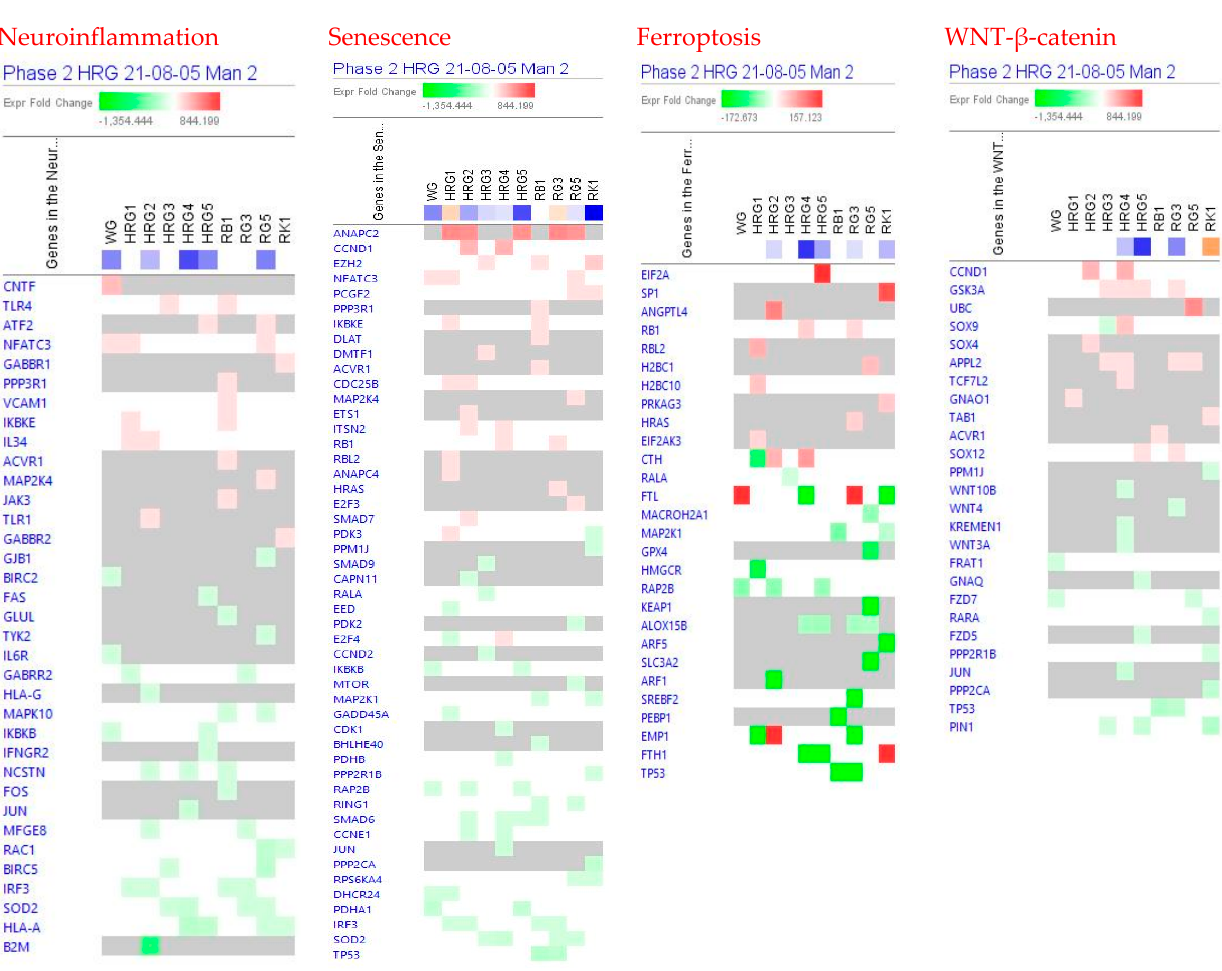
Figure 3. Effects of WG at a concentration of 10 µ g/mL, HRG at concentrations of 10 µ g/mL (HRG1), 1 µ g/mL (HRG2), 100 ng/mL (HRG3), 10 ng/mL (HRG4), and 10 pg/mL (HRG5), and ginsenosides Rb1, Rg3, Rg5 and Rk1 at a concentration of 100 nM on neuroinflammation, senescence, ferroptosis, and WNT— β -catenin signaling pathways. The heatmap of gene expression (in fold-changes compared to controls; red—upregulation, green—downregulation), after exposure of cells with test samples at different concentrations; the column represents signatures of test samples with solid red or green squares indicating genes that are expected to be upregulated or downregulated, respectively; color intensity indicates the actual log-fold changes.